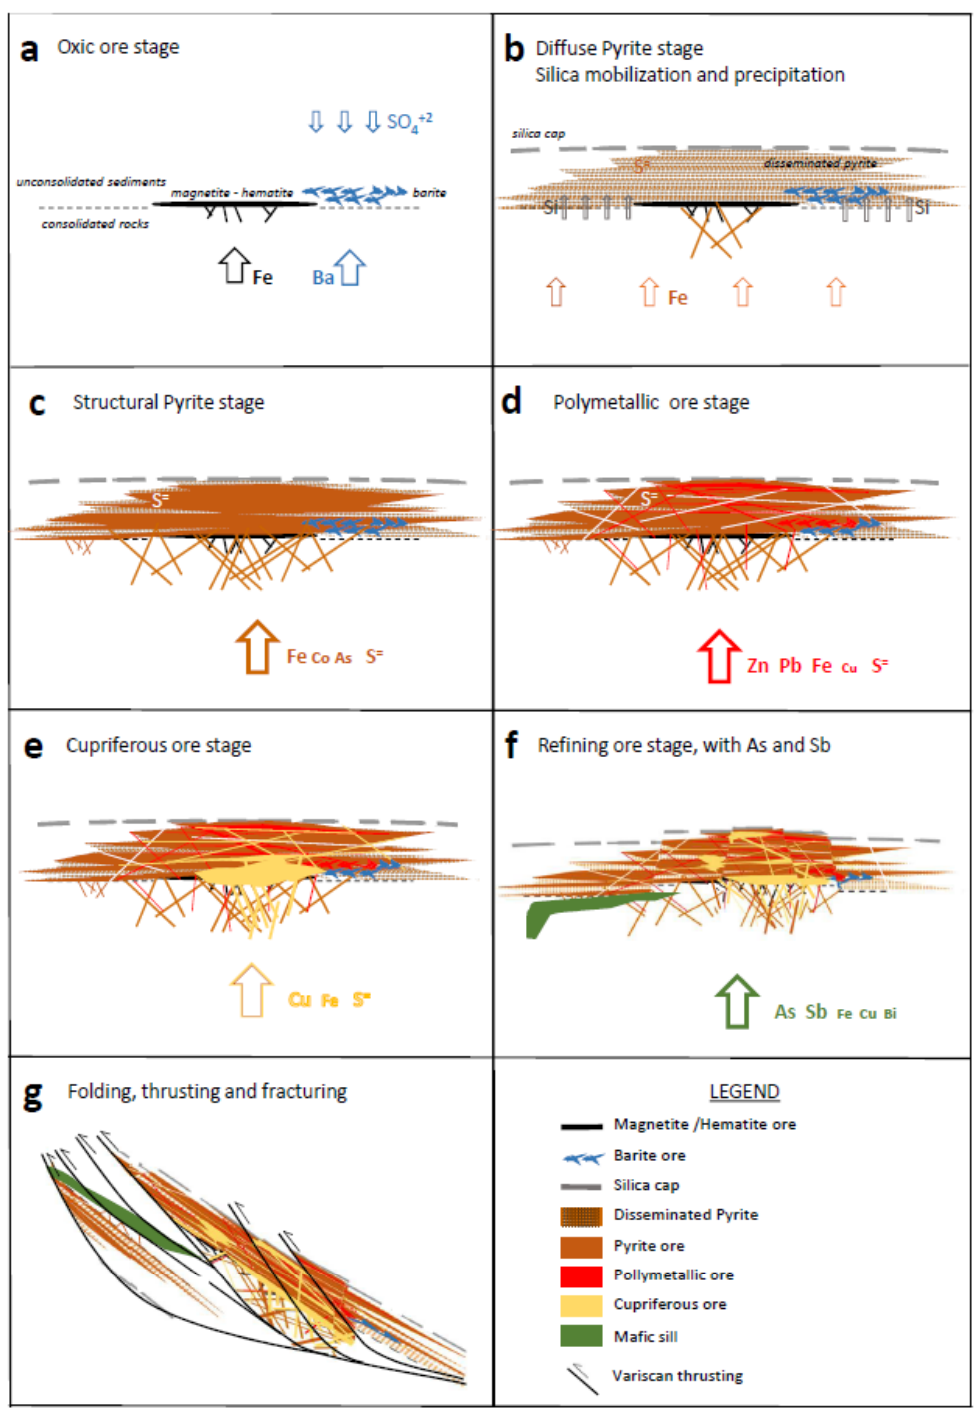
Figure 10. Seven-stage genetic model for the Iberian Pyrite Belt massive sulfides based on their mineralogical and textural evolution.